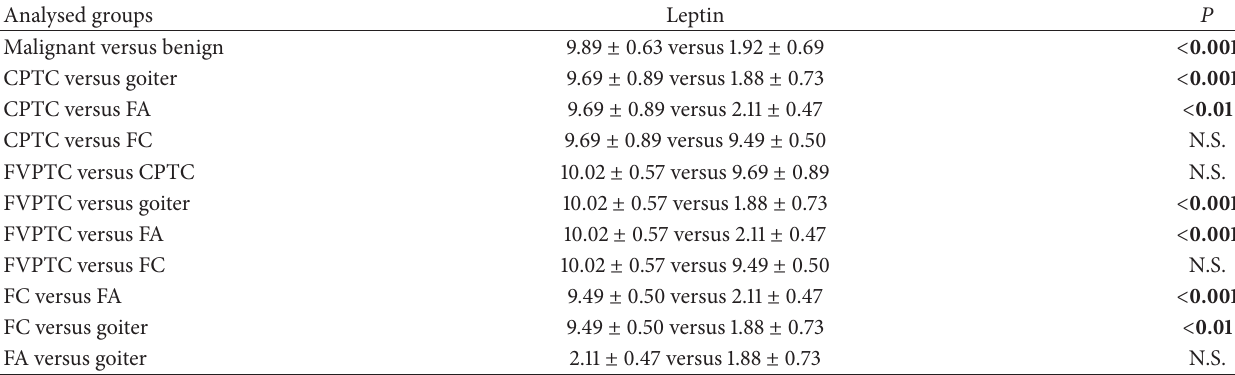
Table 1: Comparisons of different histopathological types according to their leptin serum expression. Analysed